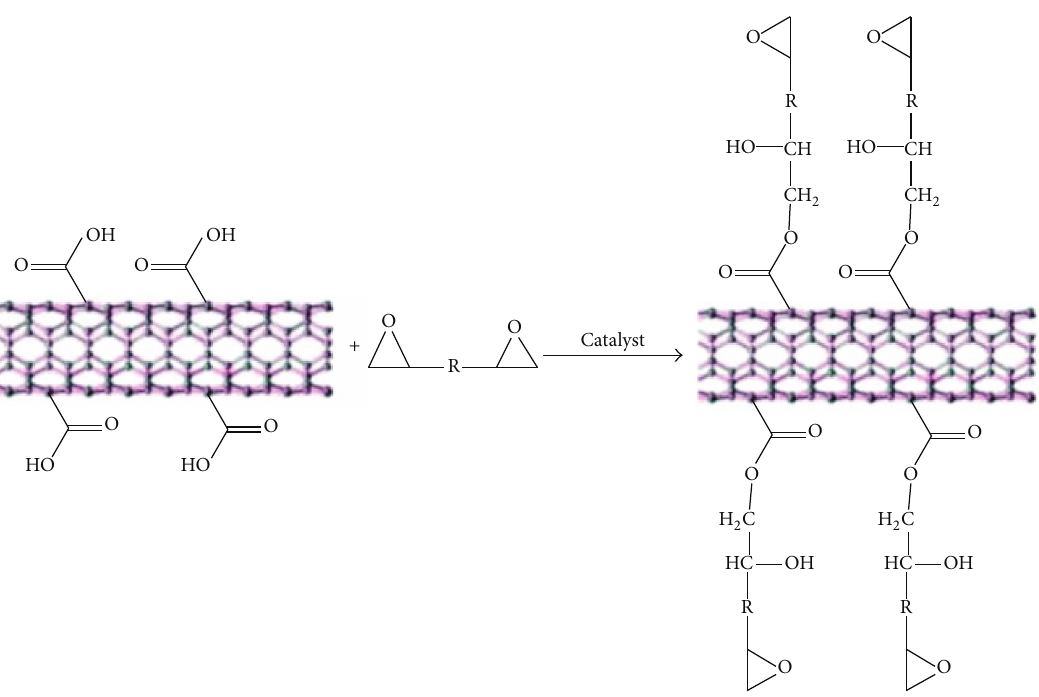
Scheme 6: Epoxy modification of